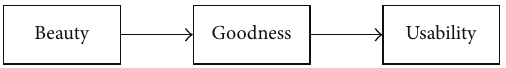
Figure 1: The effect of beauty on perceived usability mediated by